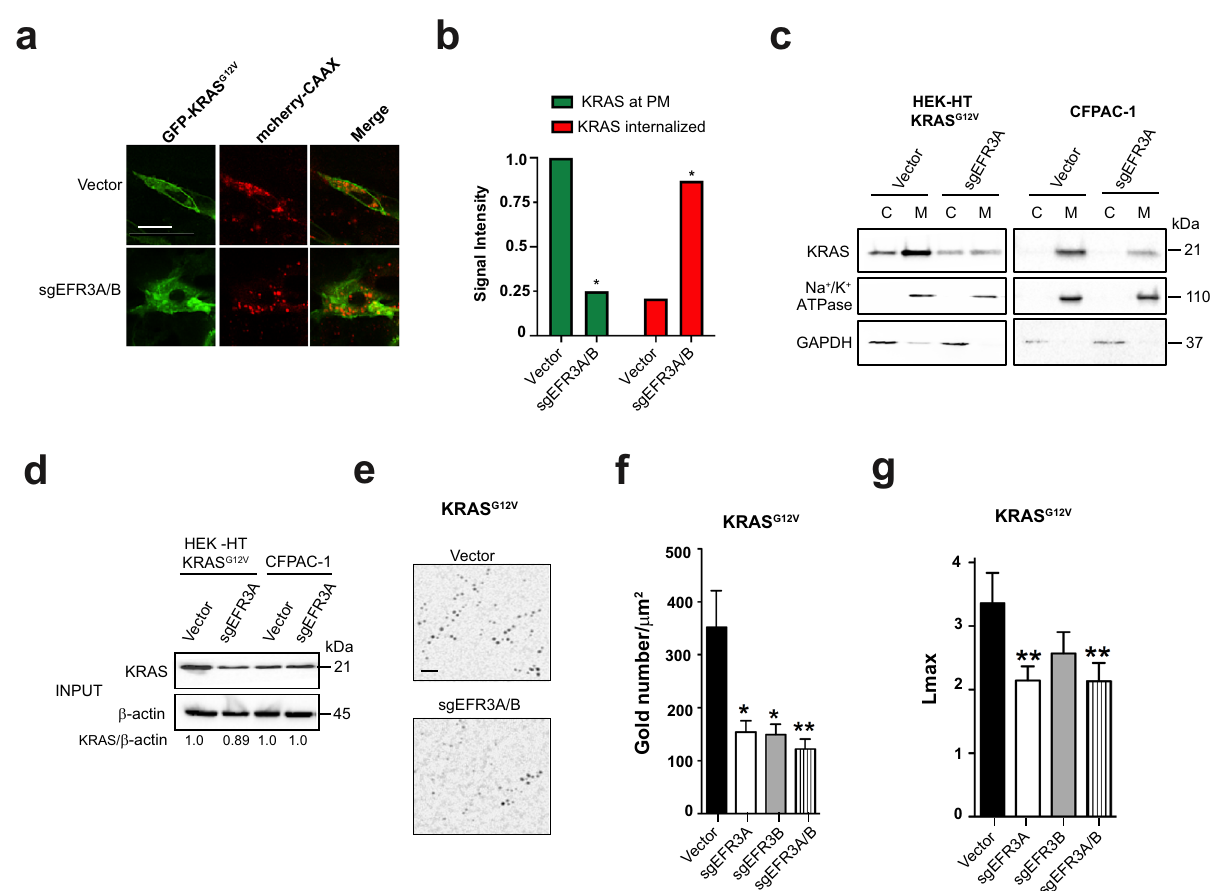
Fig. 6 EFR3A promotes the localization and nanoclustering of KRAS at the plasma membrane. a Representative confocal images showing the distribution of ectopically expressed GFP-KRAS G12V , mCherry-CAAX, or both protein (merge) in HEK-HT cells stably infected with a lentiviral vector encoding Cas9 and no sgRNA (vector) or sgEFR3A/B . Scale bar: 20 μ m. b Mean ± SD signal intensity of GFP-KRAS G12V at the plasma membrane (KRAS at PM) versus internalized (KRAS internalized) in the same two cell lines. c Levels of KRAS and Na + /K + ATPase (PM marker), and GAPDH (cytosolic marker), as assessed by immunoblot analysis, in the cytosolic (C) versus membrane (M) fraction of KRAS G12V -transformed human HEK-HT cells or the human pancreatic adenocarcinoma cell line CFPAC-1 stably infected with a lentivirus encoding Cas9 and no sgRNA (vector) or sgEFR3A . d Levels of KRAS versus actin as a loading control in the same cells from the endomembrane fraction. e – g A ( e ) representative EM micrograph showing gold conjugated, GFP-speci fi c antibody (black dots) bound to GFP-KRAS G12V , ( f ) mean ± SEM of gold particles per 1 μ m 2 of plasma membrane sheets representative of the amount of KRAS on the plasma membrane, and ( g ) the extent of nanoclustering of KRAS on the plasma membrane as measured by Lmax from human HEK-HT cells transiently expressing GFP-KRAS G12V and stably infected with a lentivirus(es) encoding Cas9 with no sgRNA (vector) or the indicated sgRNAs. Scale bar: 100 nm. a – d Representative of 3 biological replicates. e , f EM analysis is based on 30 images. Replicate experiments and full-length gels are provided in Supplementary Fig. 13. Signi fi cance values were calculated by one-sided student ’ s t test for ( b ) and two-sided bootstrap test for ( f , g ): * p < 0.05 and ** p < 0.01. S p eci fi c p values for ( b ) are 0.011 ( sgEFR3A/B KRAS at PM) and 0.024 ( sgEFR3A/B KRAS internalized), f are